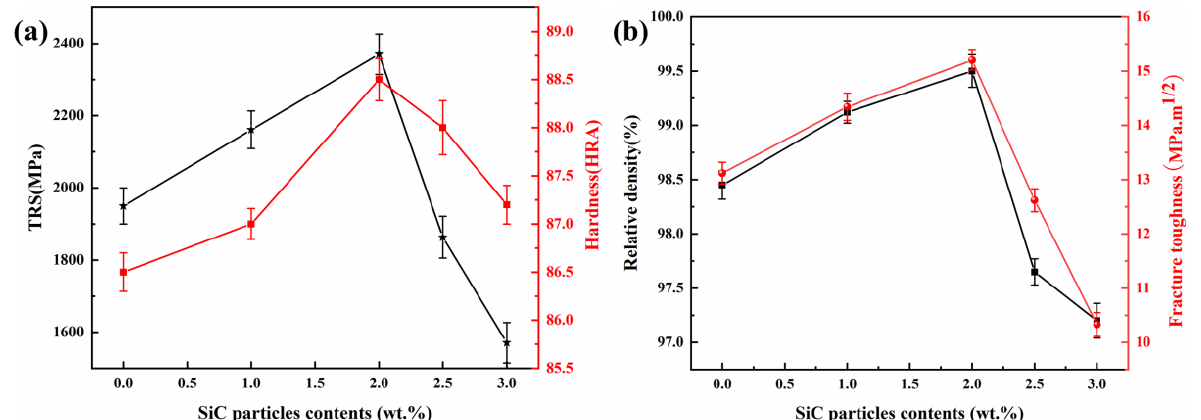
Figure 6. The variation of mechanical properties under different cermets: ( a ) TRS and hardness; ( b ) relative density and fracture toughness.